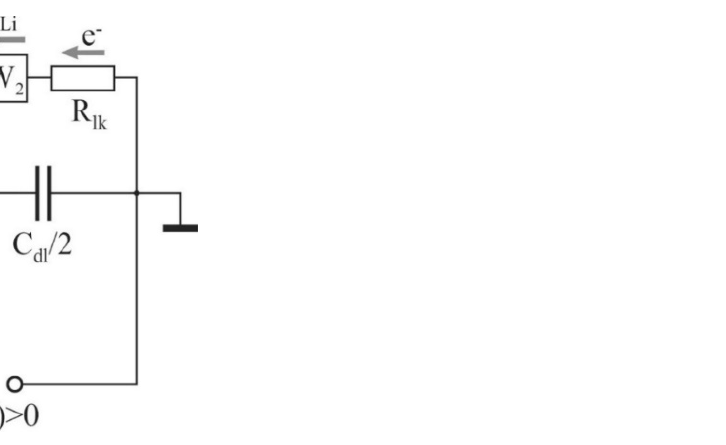
Figure 7. Simplified structural model of LiPON. The arrows show the direction of movement of charges at a positive potential on the electrode.